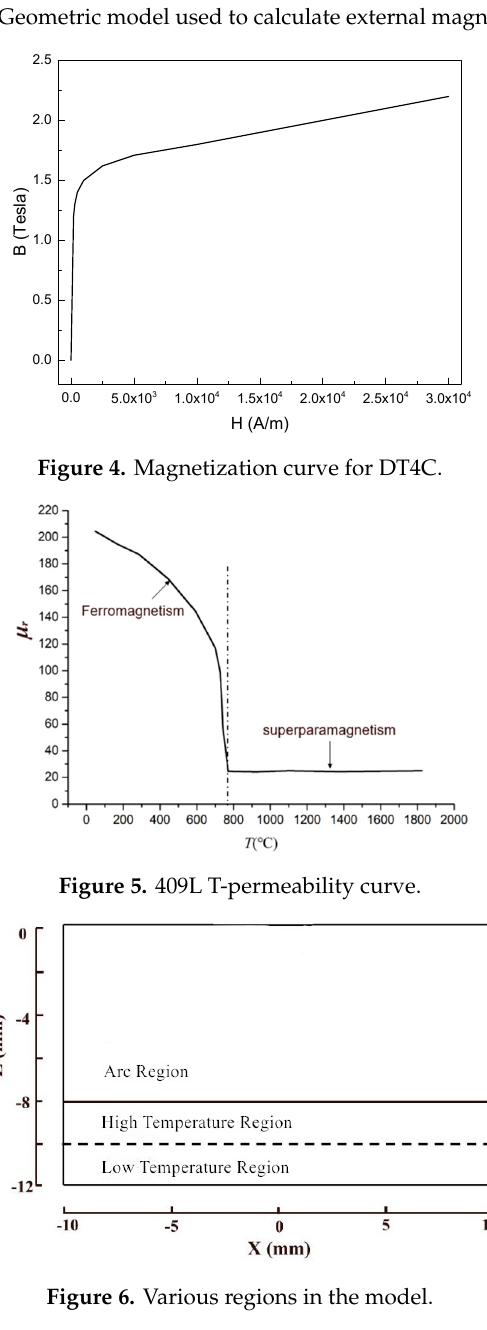
Figure 6. Various regions in the